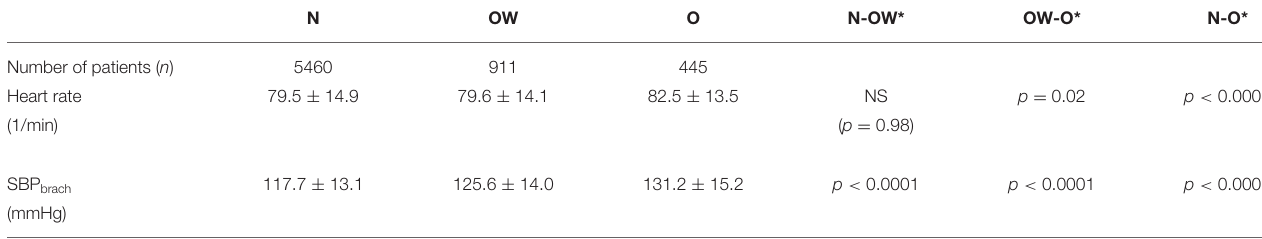
TABLE 3 | Mean heart rate and SBP brach values in N/OW/O patients.